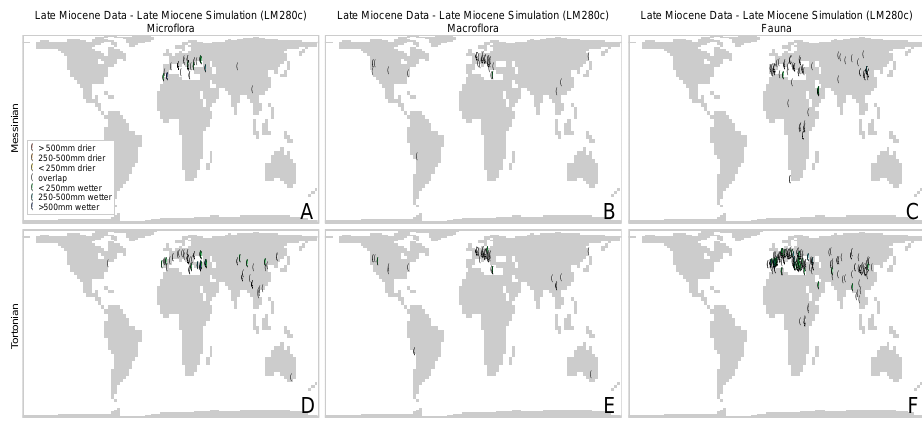
Fig. 12. Results from the model–data comparison for mean annual precipitation, late Miocene data–LM280c.